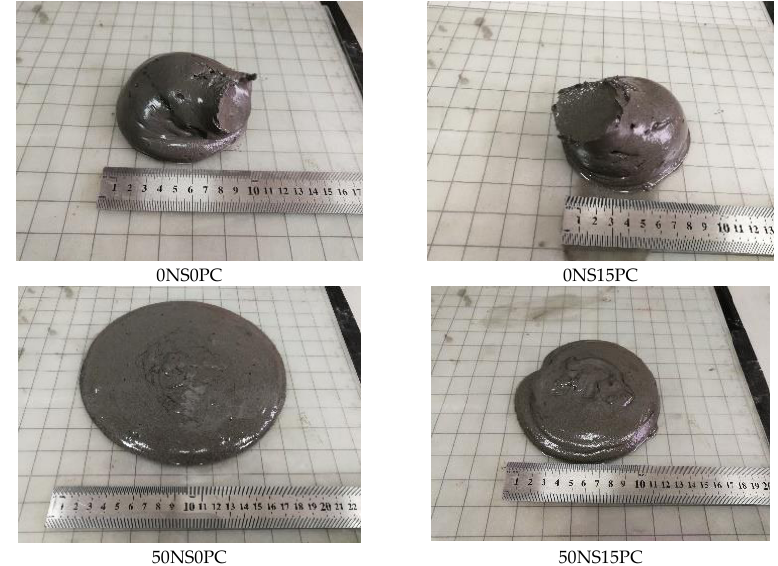
Figure 2. The flow characteristics (consistence, mm) of the alkali-activated fly ash